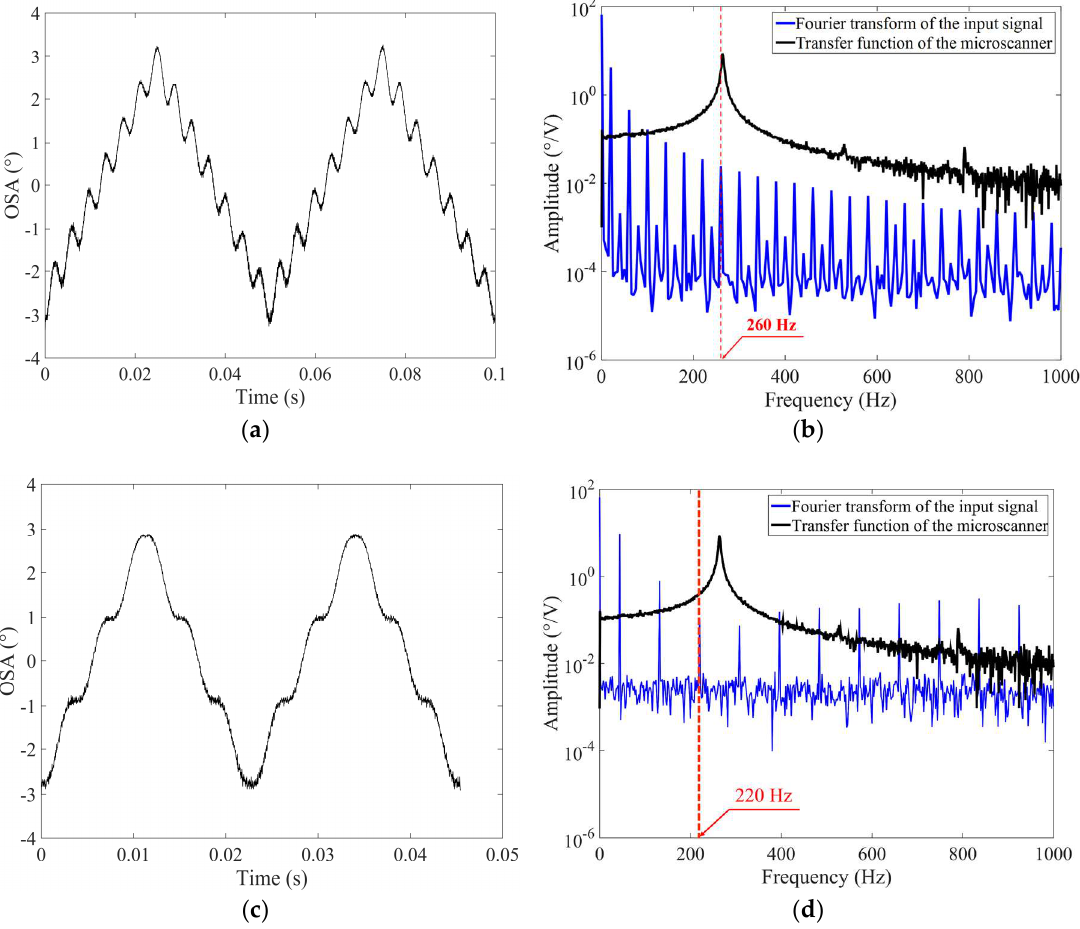
Figure 4. Exemplified dynamic response of the fabricated microscanner driven by a triangular input voltage at 20 Hz ( V d : 25 V): ( a ) scan output with severe residual oscillations in the time response and ( b ) Fourier-transformed input signal (blue) and transfer function of the microscanner (black), ( c ) scan output at 44 Hz with fewer residual oscillations, and ( d ) Fourier-transformed input signal at 44 Hz (blue) and transfer function of the microscanner (black).